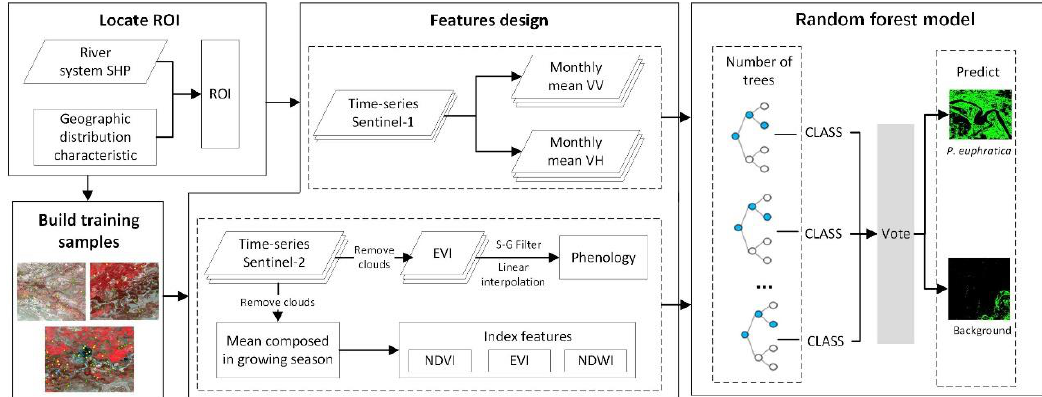
Figure 2. Workflow for large-scale P. euphratica distribution mapping in GEE.